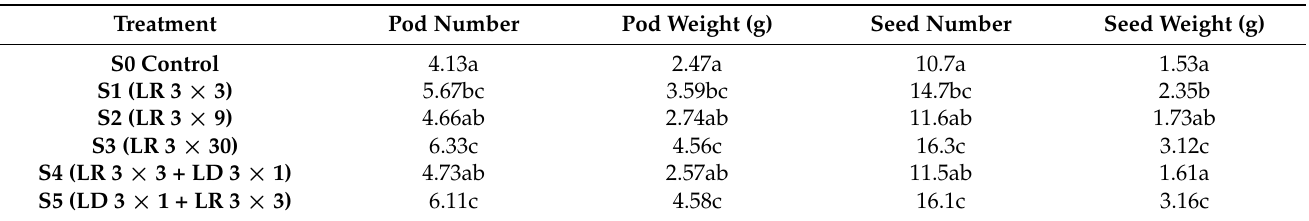
Table 6. Elements of yield structure for the main shoots of plants grown from control and laser- stimulated seeds.